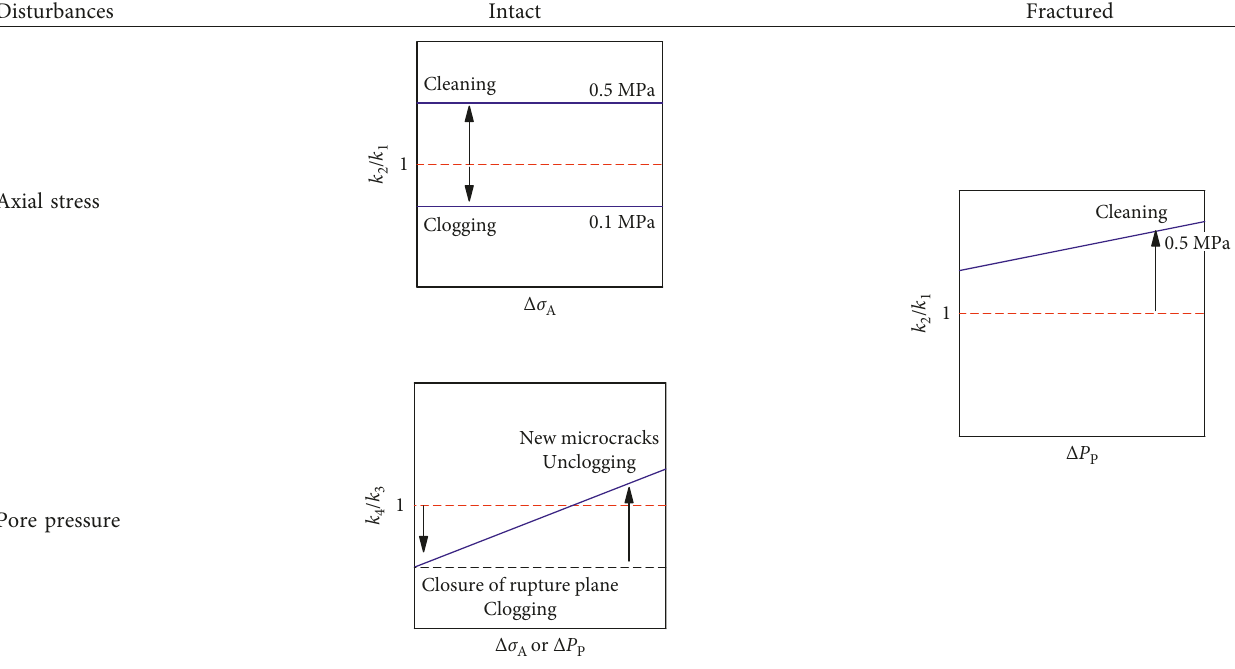
Table 7: Summary of the variations in permeability of the Shikotsu welded